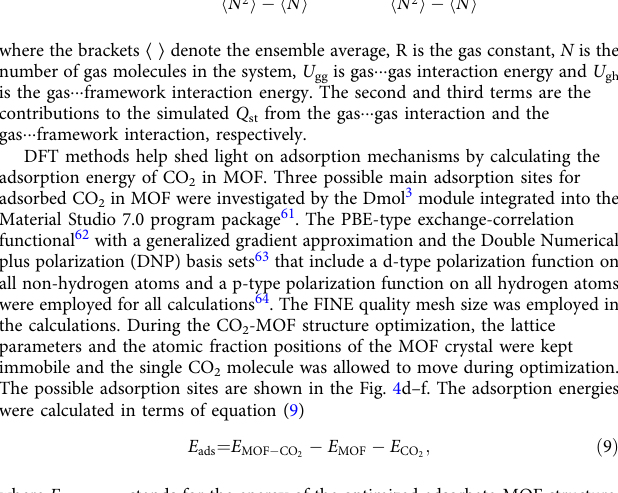
Table 5. CO 2 – CO 2 and CO 2 -framework interactions were calculated using a Lennard – Jones (LJ) +Coulomb potential. LJ parameters for the framework atoms were taken from the Dreiding Force Field except for the copper atom, for which the parameters were taken from UFF (Supplementary Table 7). The CO 2 LJ parameters were taken from an empirical TraPPE force fi eld with a partial charge on each atom (Supplementary Table 6). The mixing LJ parameters between different atomic types were calculated according to the Lorentz – Berthelot mixing rule. Lorentz – Berthelot mixing rules were used for all cross terms, and LJ interactions beyond 12.8 Å were neglected. The Ewald sum method was used to compute the electrostatic interactions. The fugacity of CO 2 was calculated using the Peng-Robinson equation of state with the corresponding parameters. Simulations for CO 2 adsorption used 100,000 cycles for equilibration and 100,000 cycles for data collection. In a cycle, N Monte Carlo moves were performed, where N is whichever value is larger between 20 and the number of molecules in the system. Monte Carlo moves used with equal probability were translation, rotation, insertion, deletion, and random reinsertion of an existing molecule at a new position, while framework atoms remained fi xed at simulations using the expression (equation